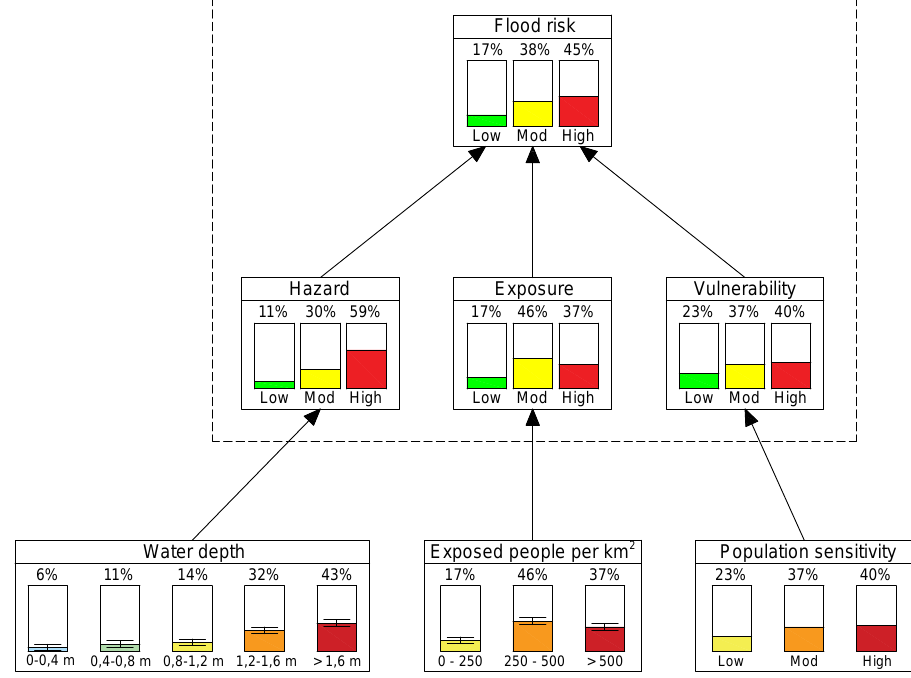
Figure 10. Bayesian network flood risk model applied considering the 2014 flood event.